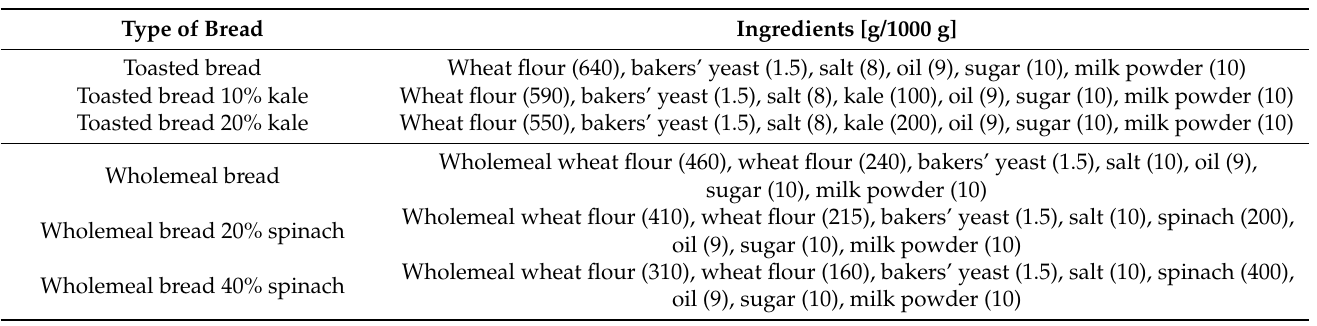
Table 1. Tested bread